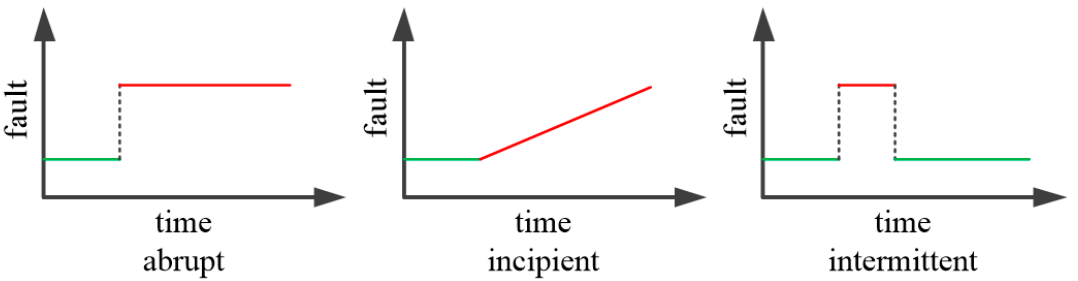
Figure 1. Fault classification according to time characteristics.